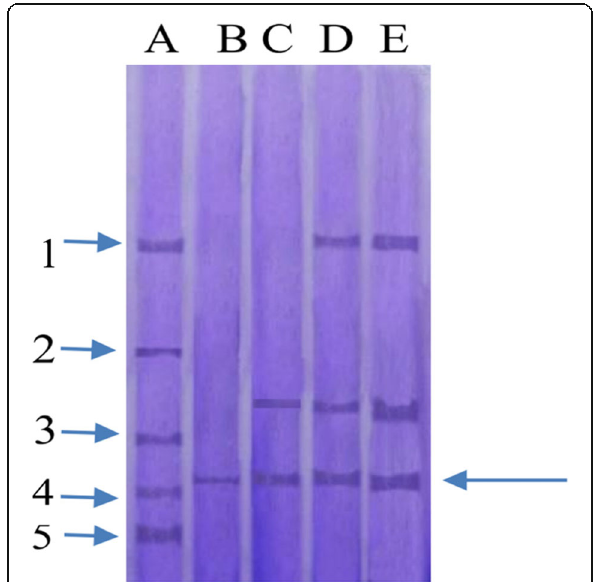
Fig. 3 Electrogram of SDS-polyacrylamide gel electrophoresis of the storage protein of the aerial tuber of D. bulbifera . PAGE was carried out in the presence of SDS using the discontinuous Tris-glycine buffer system. The separating gel was 10%, and stacking gel was 3.5% acrylamide. Other conditions were as described in text. Lane A: standard proteins; B: gel filtration pooled fractions; C: ion exchange pooled fractions; D: ammonium sulphate precipitate; E: crude extract